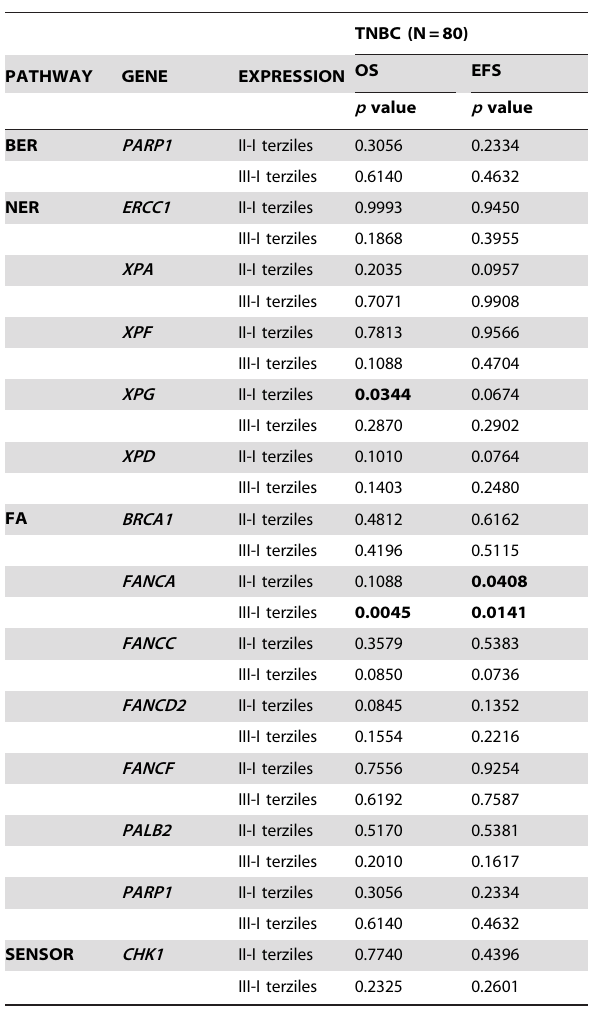
Table 5. Overall survival and event-free survival in triple negative breast cancer patients by expression of the different genes (univariate analysis, categorization based on